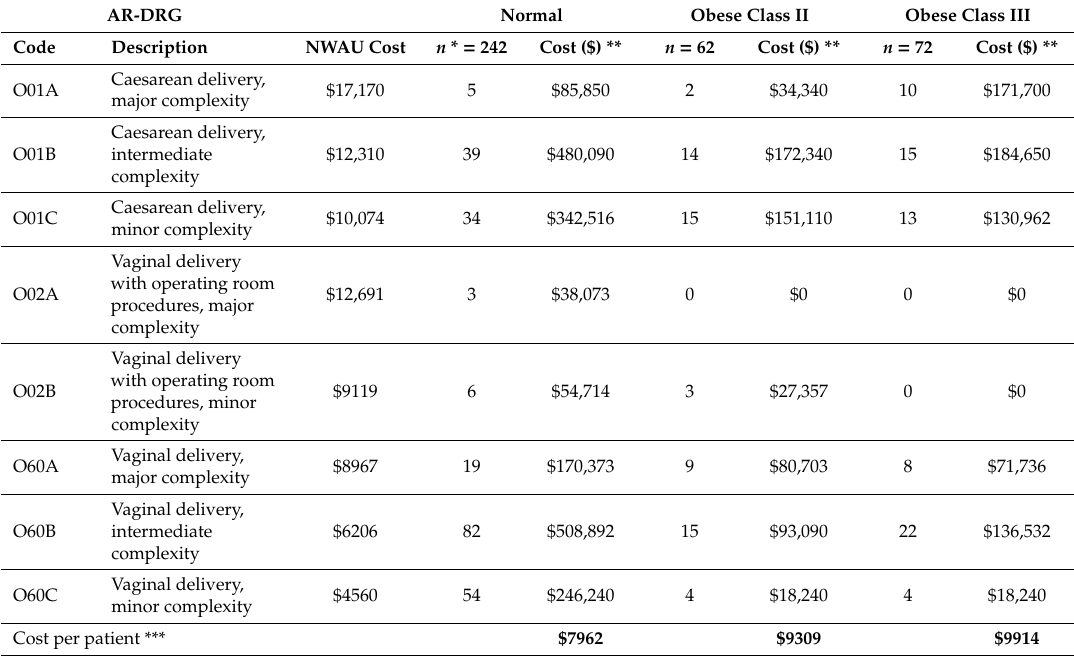
Table 5. Maternal birth admission Australian Refined Diagnosis Related Group (AR-DRG) classification (with description and price ($AUD, 2020) and mean cost per patient for study participants in BMI categories normal and obese class II and